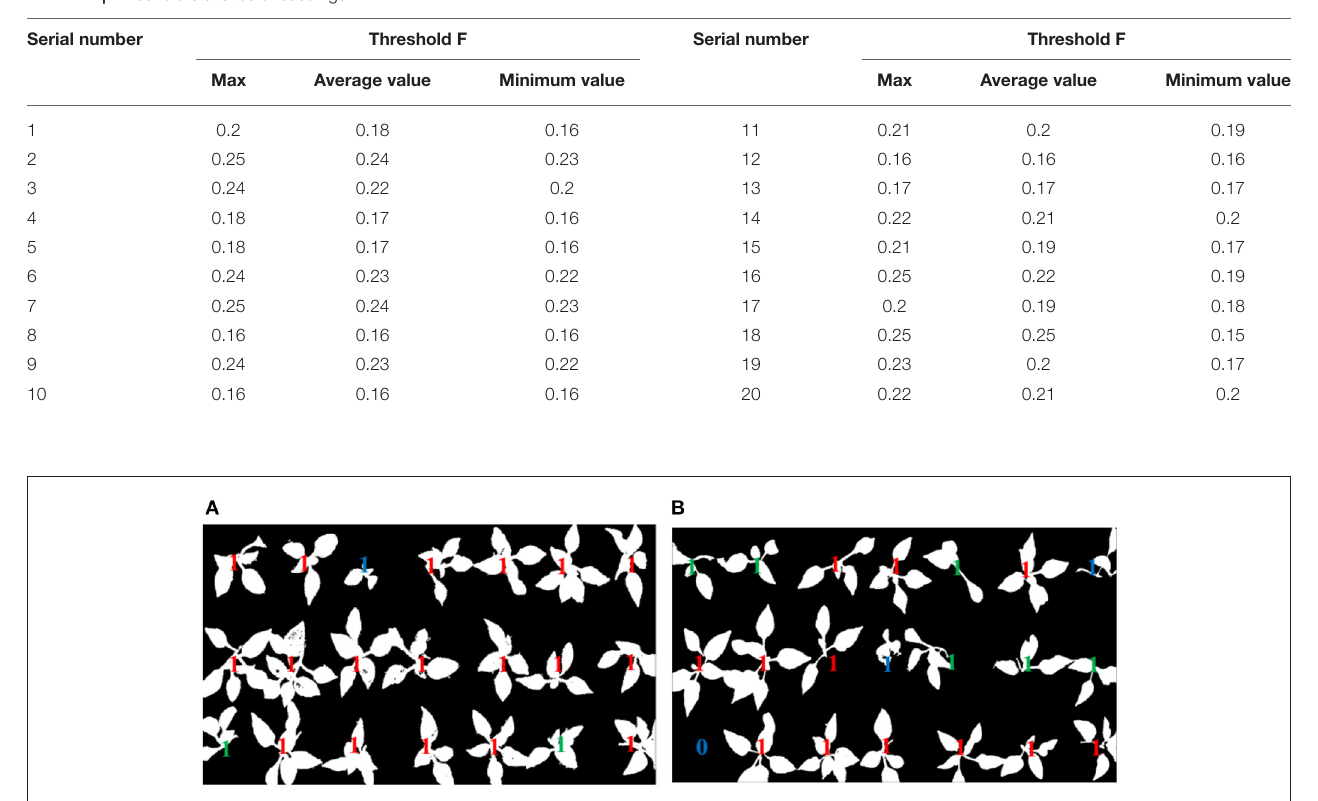
FIGURE 8 | Identification results based on the proposed method.